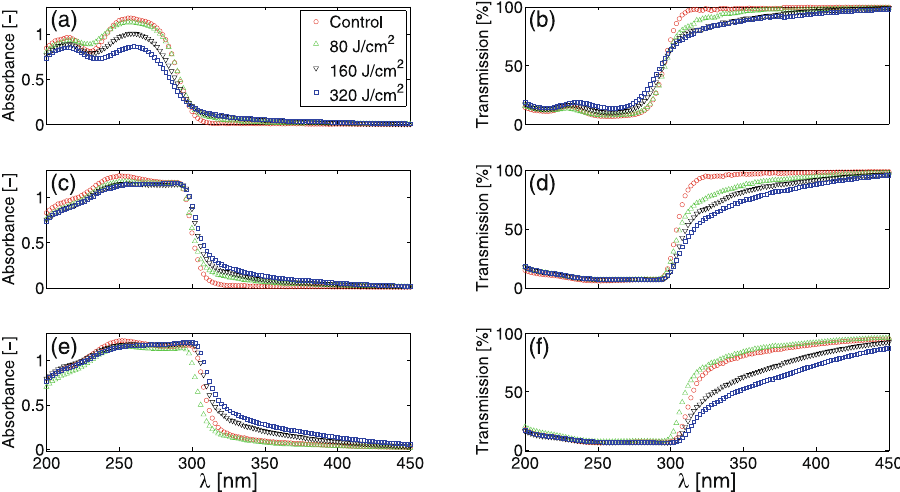
Figure 3. Effects of UVB irradiation. Absorbance (left column) and transmission (right column) plotted against wavelength, λ , for films with a surface density of 0.0031 mg/mm 2 (top row), 0.0124 mg/mm 2 (middle row) and 0.031 mg/mm 2 (bottom row). Each of the panels ( a – f ) display the average (n = 3 individual films for each dosage) absorbance or transmission spectrum prior to UVB irradiation (Control: red circle) and after UVB dosages of 80 J/cm 2 (green triangle), 160 J/cm 2 (black inverted triangle) and 320 J/cm 2 (blue square). Standard deviations in all cases are smaller than the symbol size and have not been plotted to improve visual